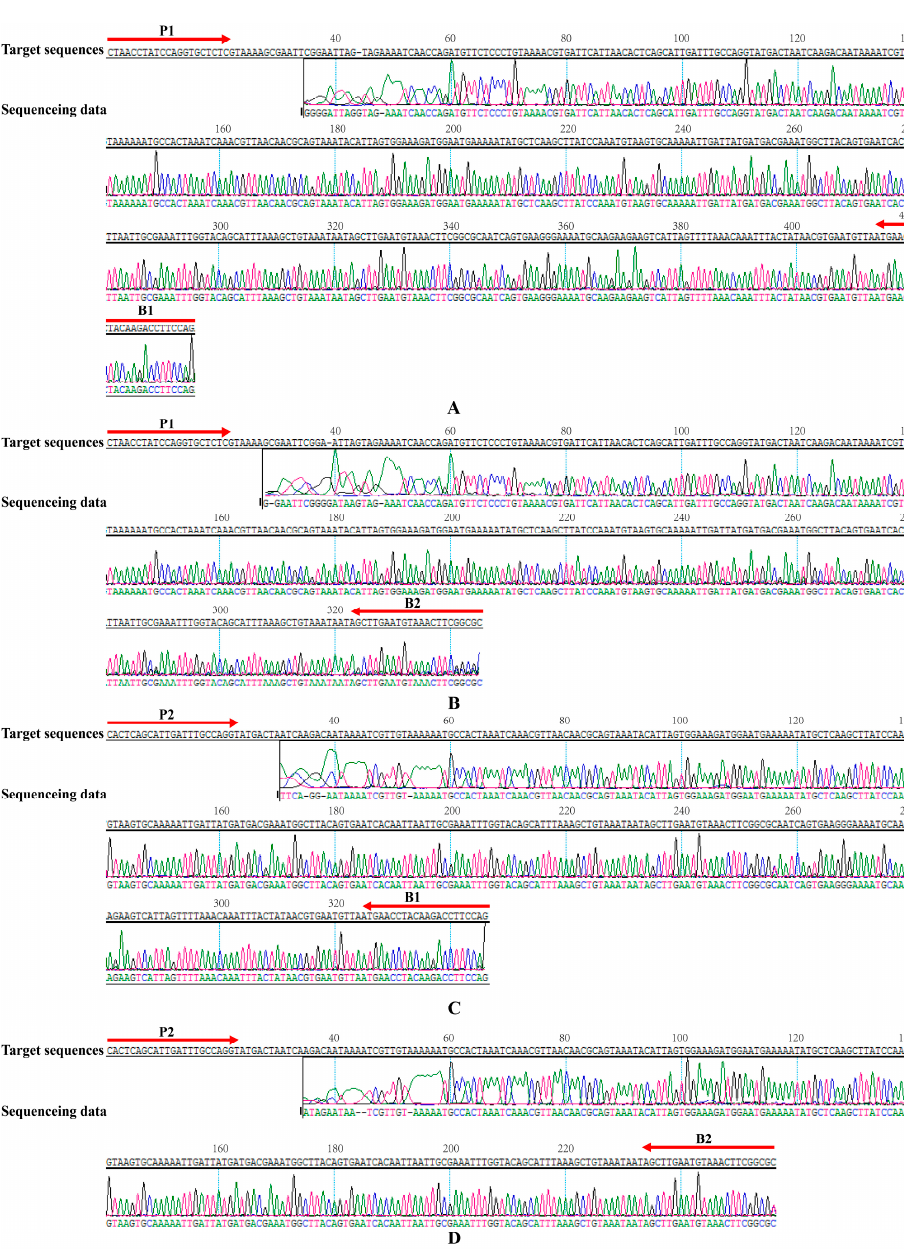
Figure 6. Sequencing analysis of MIP-LAMP amplified L. monocytogenes hlyA gene. The target sequences were presented at the top and the sequences of the primers sites (P1, P2, B1 and B2) were underlined. ( A – D ): the sequencing data were obtained from primers P1 and B1, P1 and B2, P2 and B1, P2 and B2, respectively. Left and right arrows indicated complementary and sense sequences that were used. The sequencing data were shown in the